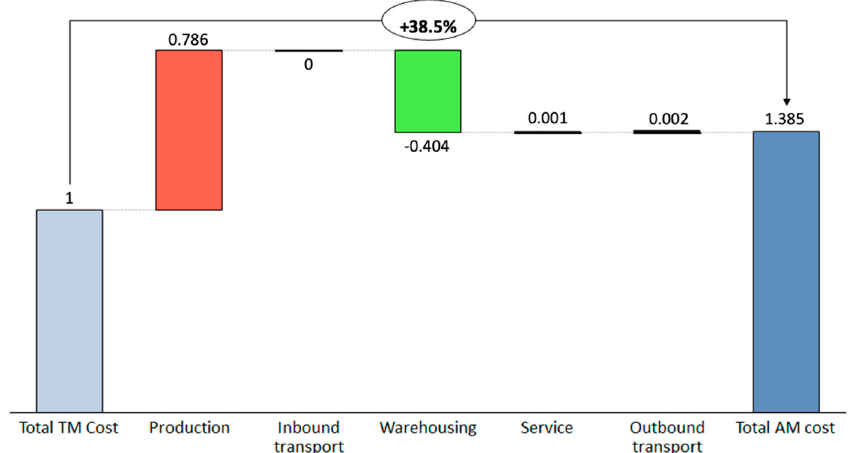
Figure 5. SPSC total cost difference between AM and TM for P3, shown in normalized values.